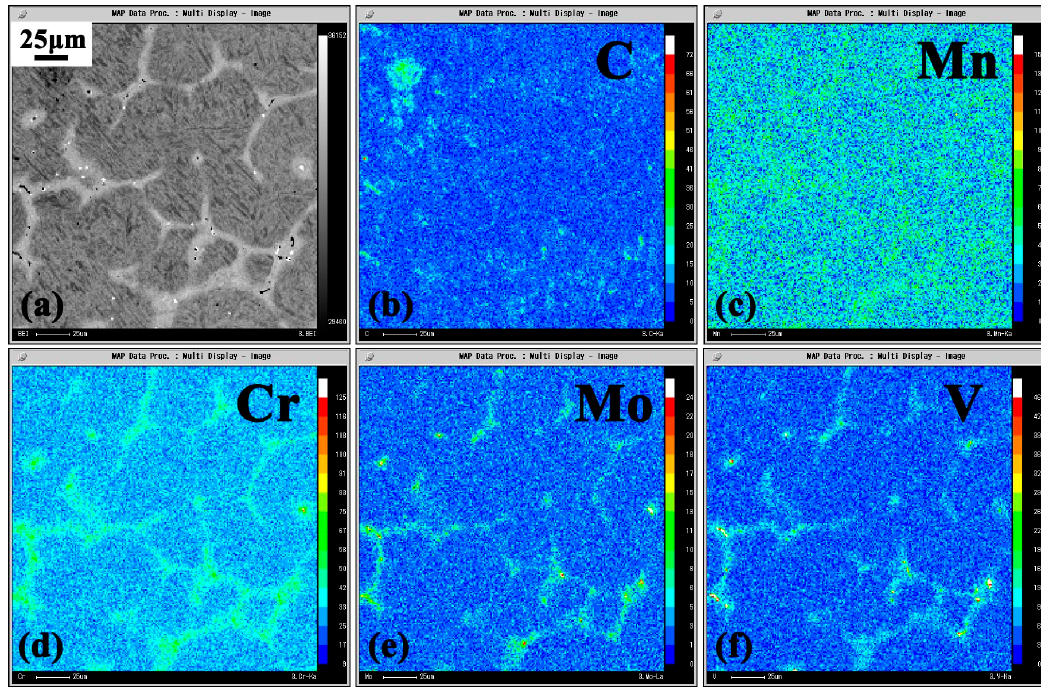
Figure 6. Characterization of “circle-like” structures when deformed at 1360 °C. ( a ) Back scatter mode, ( b – f ) are C, Mn, Cr, Mo, and V elemental distributions, respectively.